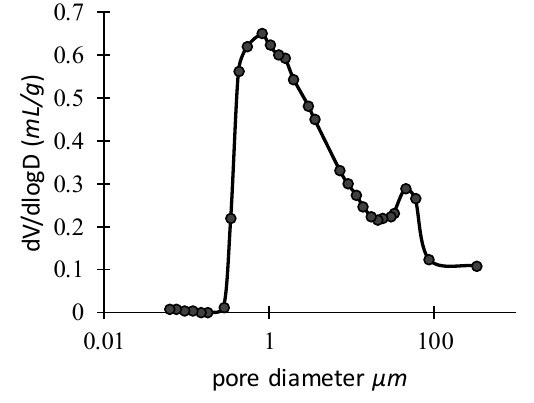
Figure 2. Pore size distributions obtained by mercury intrusion.